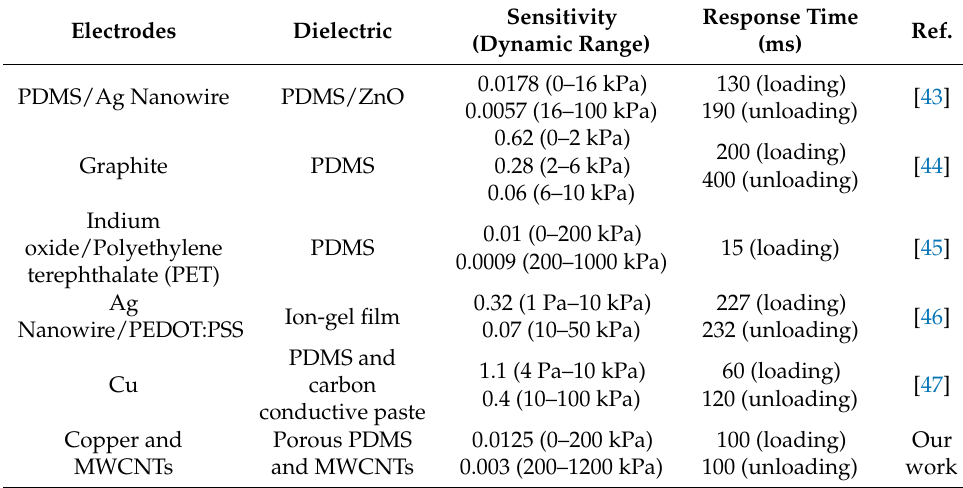
Table 1. Comparison of performance of different capacitive